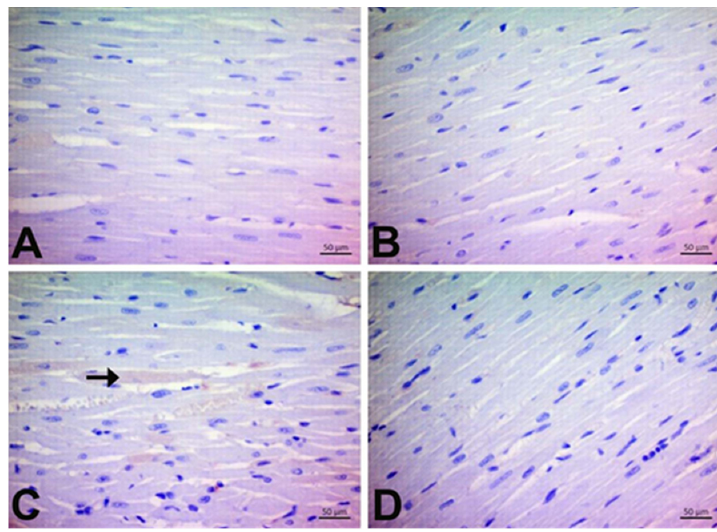
Figure 8. Immunohistochemical staining of 4-HNE in experimental groups in cardiac tissue (×400). 4-HNE expression levels were significantly elevated in DOX-treated rats, while CGA-treated rats demonstrated a significant decline in 4-HNE expression. Arrowhead: Intensity of immunoreactivity. ( A ) Control, ( B ) CGA, ( C ) DOX, and ( D ) DOX + CGA. Data are presented as the means ± SD. CGA: Chlorogenic acid (100 mg/kg); DOX: Doxorubicin (15 mg/kg); CGA: Chlorogenic acid (100 mg/kg); DOX: Doxorubicin (15 mg/kg); 4-HNE: 4-Hydroxynonenal.